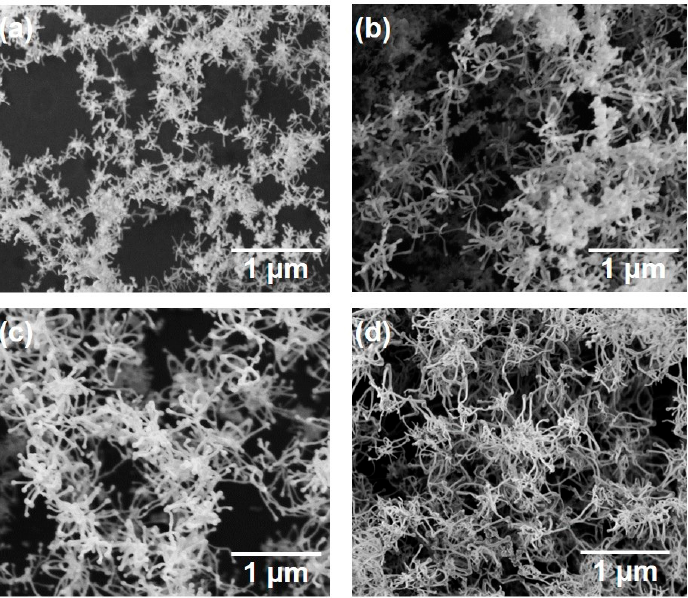
Figure 6. SEM photographs of silicon nanomaterials generated at various pulse widths: ( a ) 1, ( b ) 2, ( c ) 5, and ( d ) 10 ms.